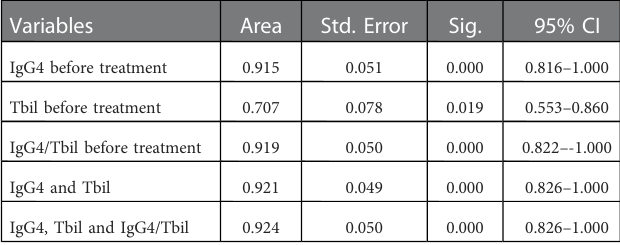
TABLE 3 ROC analysis of IgG4 level before treatment and Tbil level before treatment in the diagnosis of AIP.